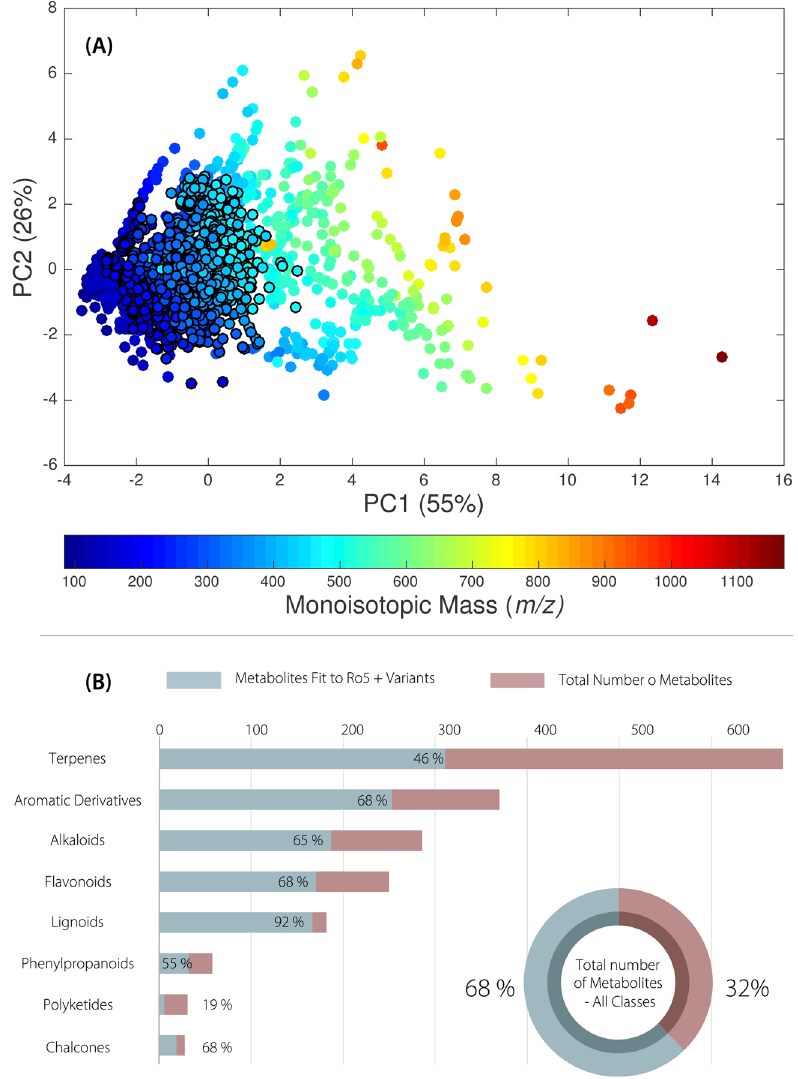
Figure 7. ( A ) Principal component analysis applied to molecular descriptors (physicochemical properties) of the compounds present in the NuBBE DB . The gradient of colors represents the compound distribution as a function of the monoisotopic mass variable. Black borderlines were added to denote compounds obeying the Lipinski-Veber rules. ( B ) Pie chart representing the total number of compounds (from all metabolic classes) that obey the Ro5 and Variant rules and bar graphs representing the compound distributions for different metabolic classes are